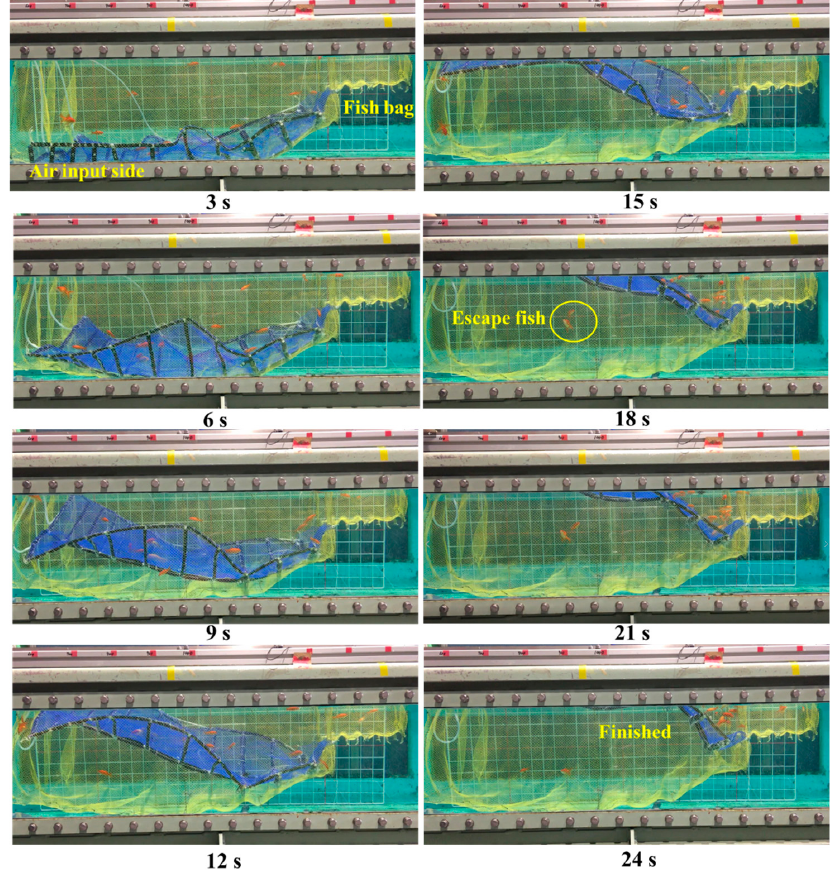
Figure 13. Fish school behavior in the hauling up process for case 2.